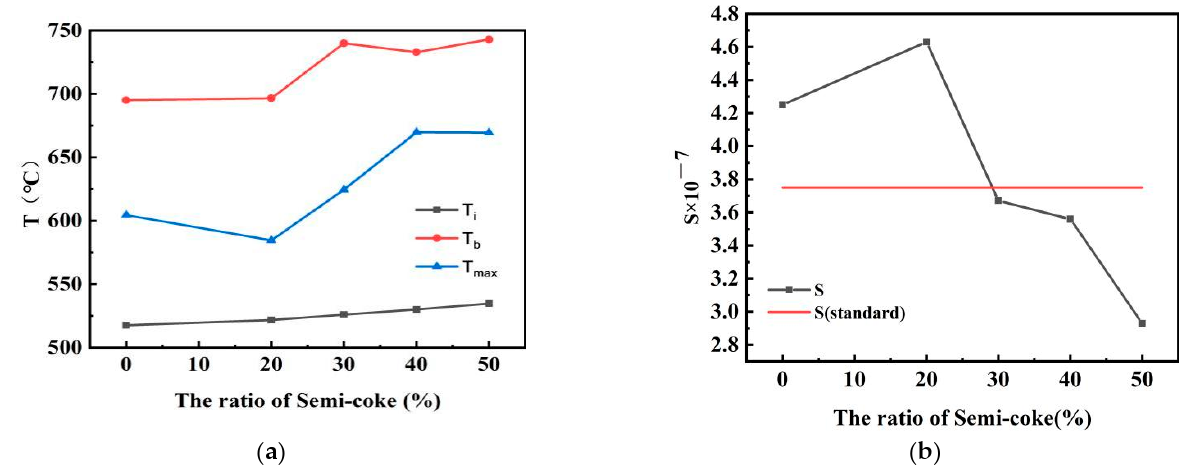
Figure 3. Combustion characteristics parameters of the mixture of semicoke and bituminous coal with different addition ratios: ( a ) Ti, Tb, Tmax, and ( b ) S for different semicoke ratios in mixed pulverized coal. Table 3. Combustion characteristic parameters of the mixture of semicoke and bituminous coal with different addition ratios.